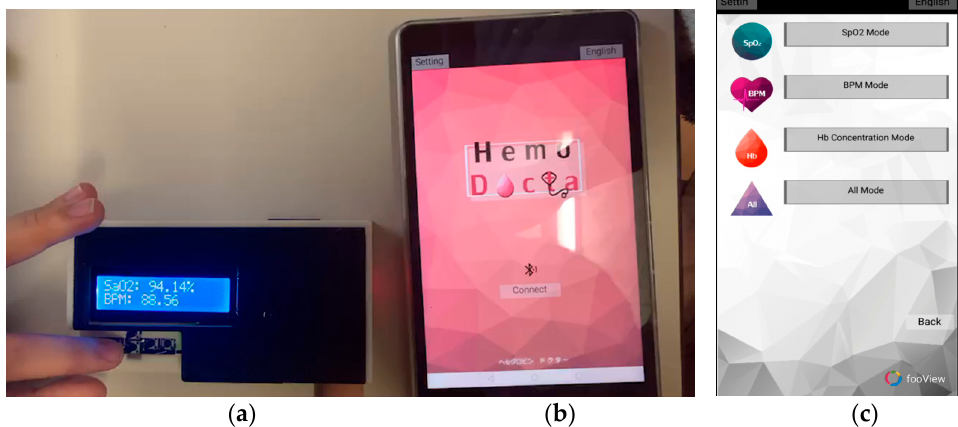
Figure 12. Portable hemoglobin concentration monitoring system: ( a ) hardware, ( b , c ) software.